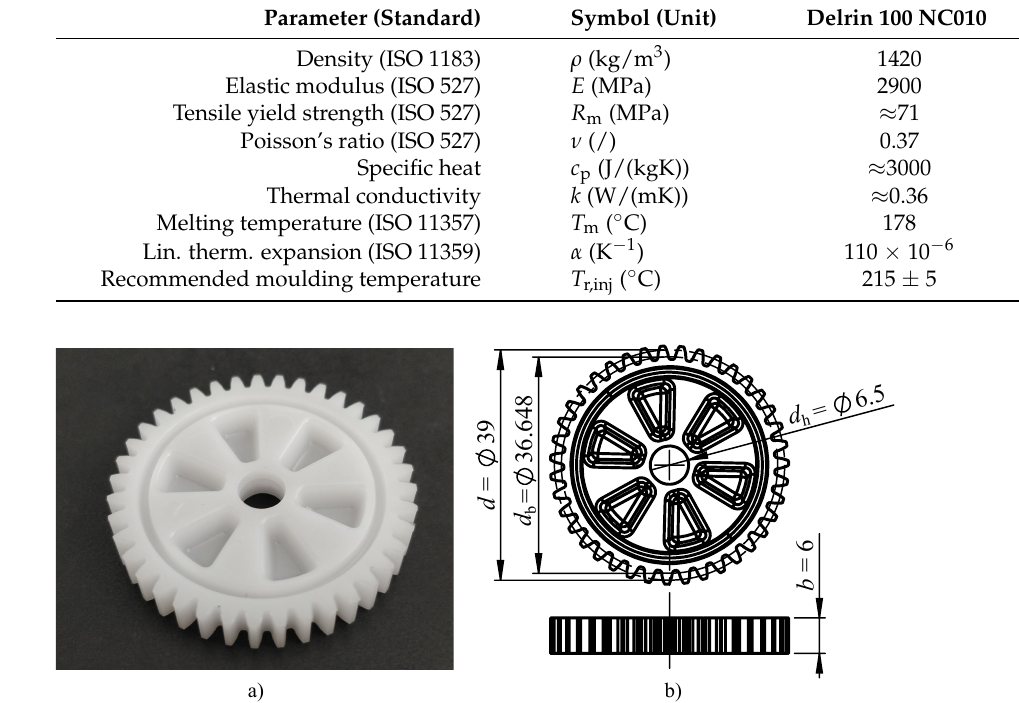
Table 1. General thermomechanical parameters of the used polymer.